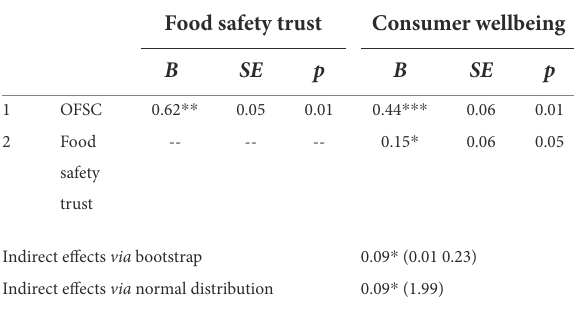
TABLE 2 Discriminant validity test results.